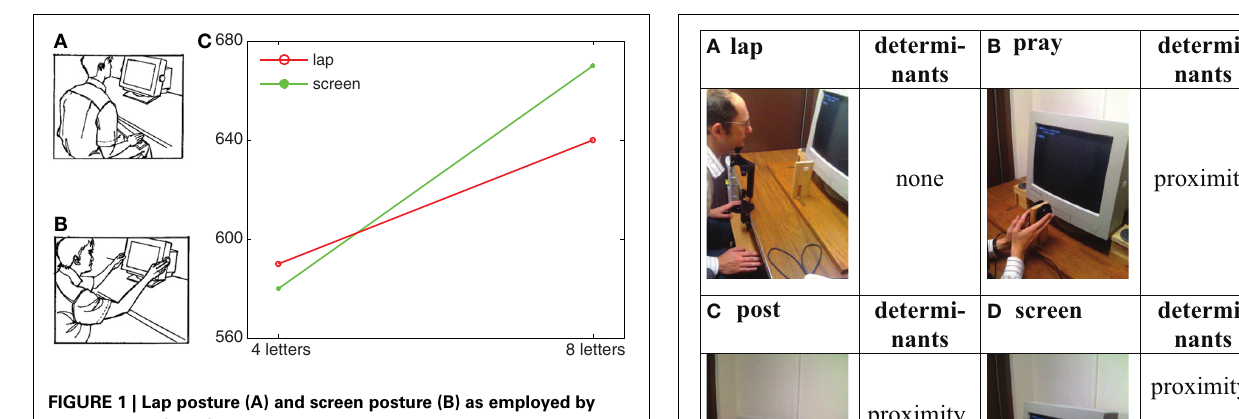
in the parietal and premotor cortices (Graziano and Gross, 1993;